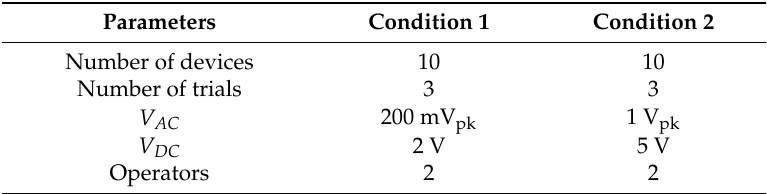
Table 2. Electrostatic force